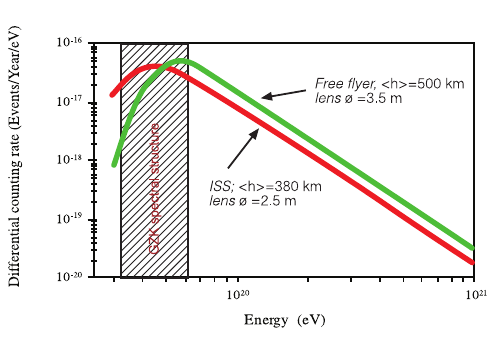
Fig. 10 . Differential EECR counting rate comparison between the ISS version of the EUSO and the original free fl yer. The dashed zone shows the spectral region where structure induced by the GZK cut-off is ex- pected. The lens diameter is the maximum external diameter allowed in each confi guration.